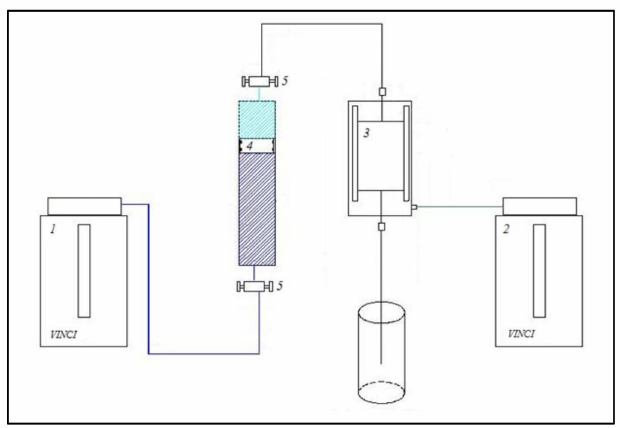
Figure 3. Schematic diagram of the filtration unit. (1—HP pump 100-10, 2—pump (to create a cut), 3—core holder, 4—piston storage device, 5—valve).